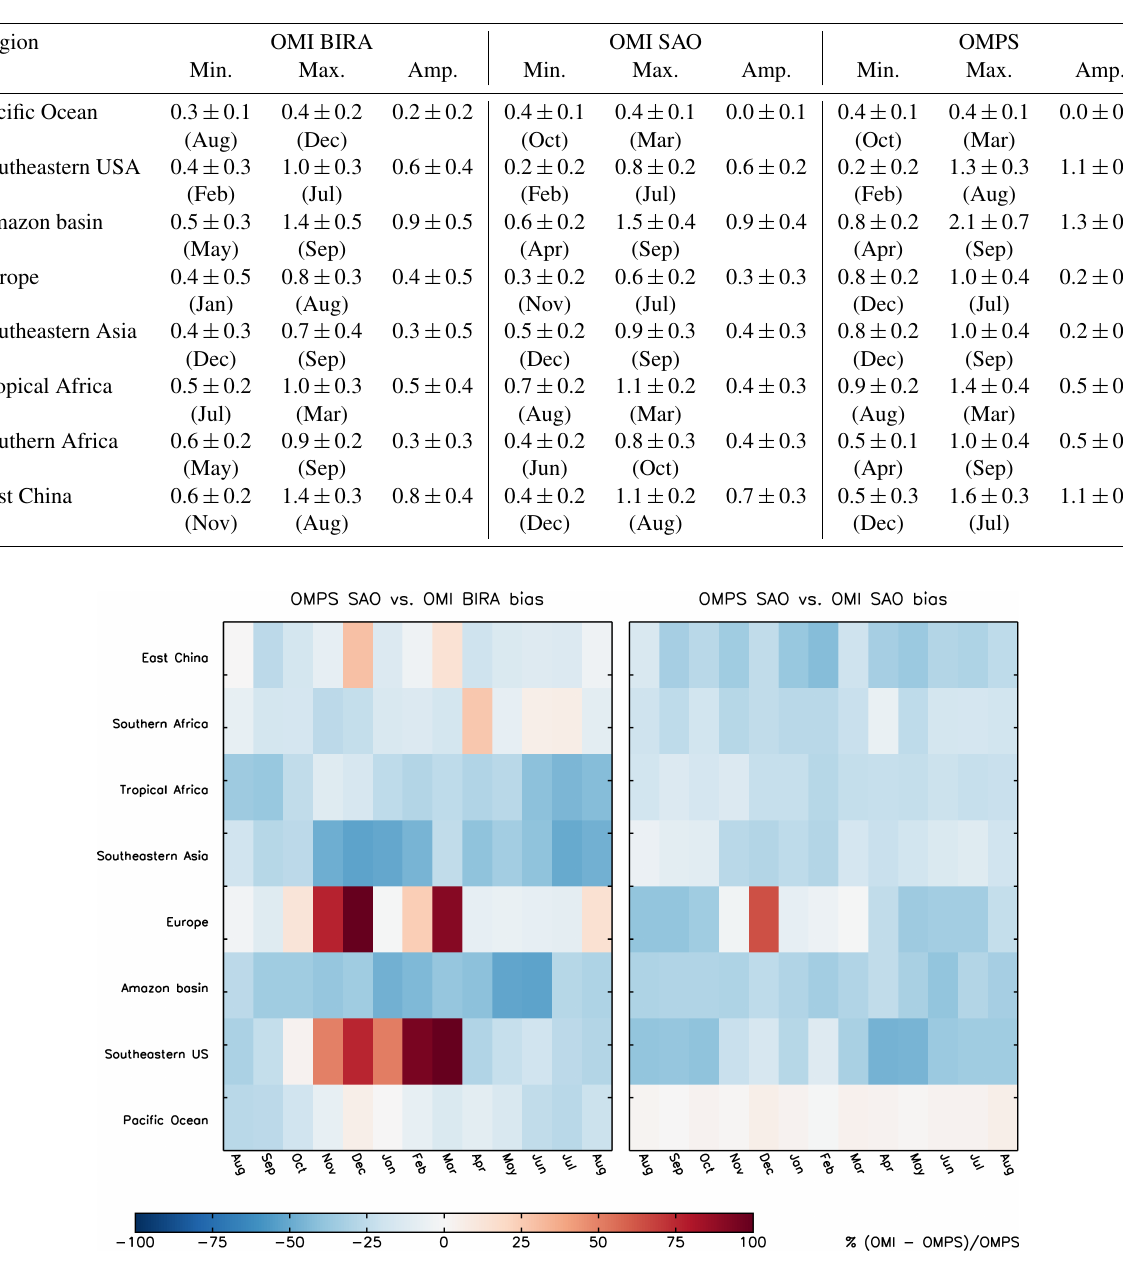
Figure 9. Monthly mean offsets between OMPS SAO retrieval and OMI retrievals from BIRA (left panel) and SAO (right panel). The offsets are expressed as percent of the OMI retrieval minus the OMPS retrieval. As expected the biases between OMPS SAO and OMI BIRA retrievals are bigger than the biases between OMPS SAO and OMI SAO. Southern Africa, Europe, and southeastern USA show the most relevant